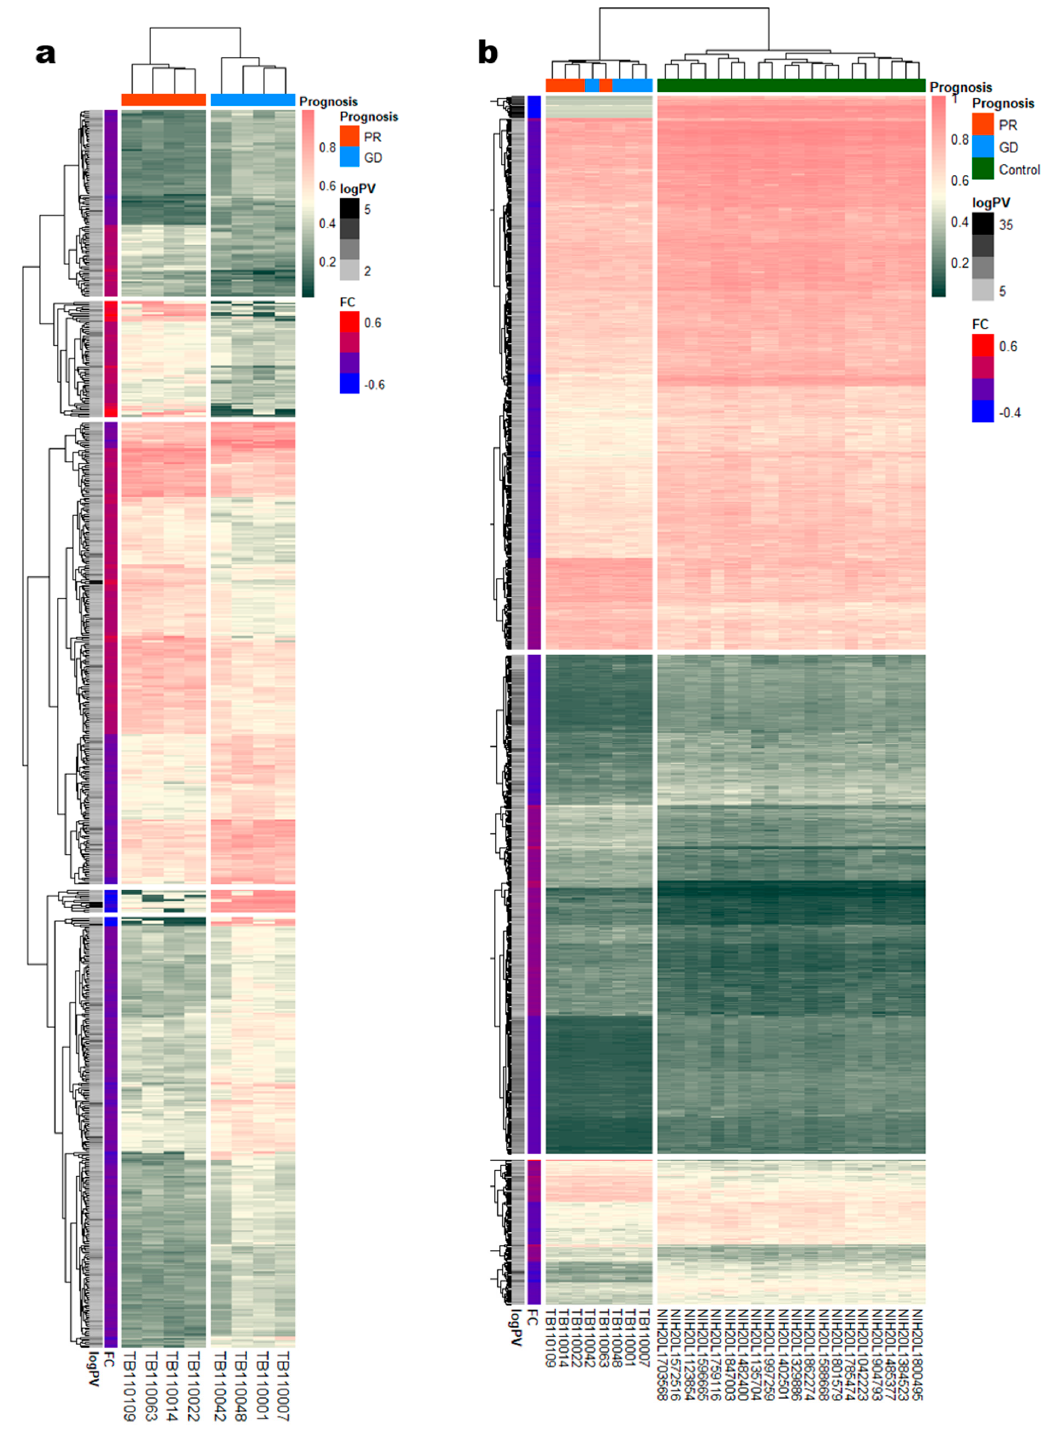
Figure 1. Differential DNA methylation between the NTM prognosis groups and between patients with NTM and healthy controls. ( a ) Heatmap depicting the fold change in methylation between NTM patients with good or poor prognosis. There were 754 DMRs; the poor prognosis group (red row, PR) accounted for 461 more methylated DMRs, and the good prognosis (blue row, GD) group accounted for 293 more methylated DMRs. Unsupervised clustering of eight samples was observed between the prognosis groups. ( b ) Heatmap depicting the fold change between patients with NTM and healthy controls. There were 1108 DMRs; the NTM patient (red column annotation bar, PR; blue column annotation bar, GD) group accounted for 337 more methylated DMRs, and the control (green column annotation bar, GD) group accounted for 771 more methylated DMRs. Unsupervised clustering of 28 samples was observed between patients with NTM and the